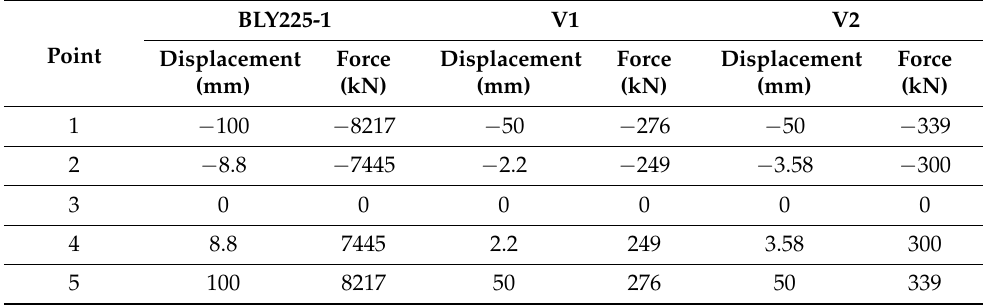
Table 2. Input multilinear force-displacement relation parameters.